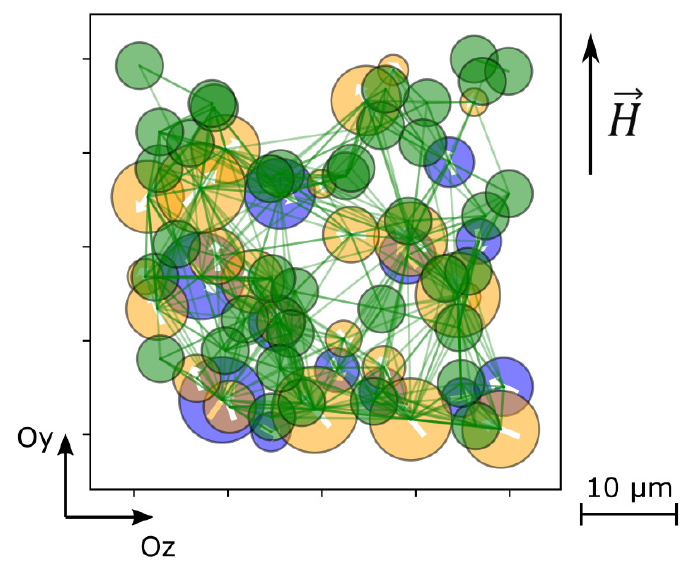
Figure 2. Snapshot of the test box; blue spheres are FM particles, orange ones are FE particles, white arrows show their magnetic/electric polarizations, green spheres are polymeric beads, green lines denote elastic links; the snapshot region is 10 × 50 × 50 μ m along Ox , Oy, and Oz axes, respectively.